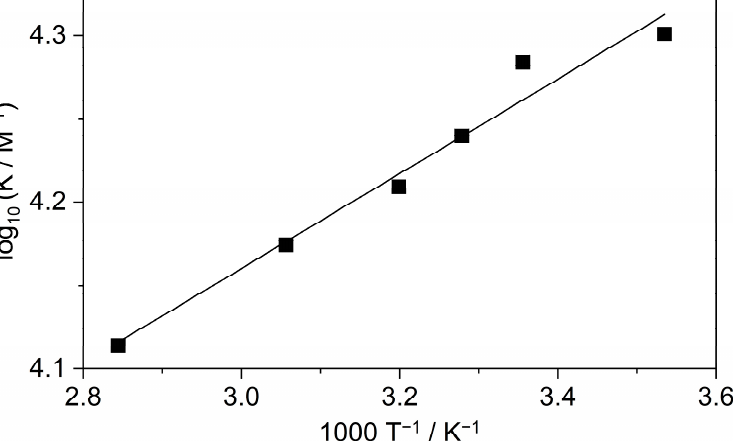
Figure 4. The van’t Hoff plot of the association constant of B confinement in SBE 6.4 β CD. The line displays the result of the nonlinear least-squares fit of the temperature dependence of K values by Equation (1).